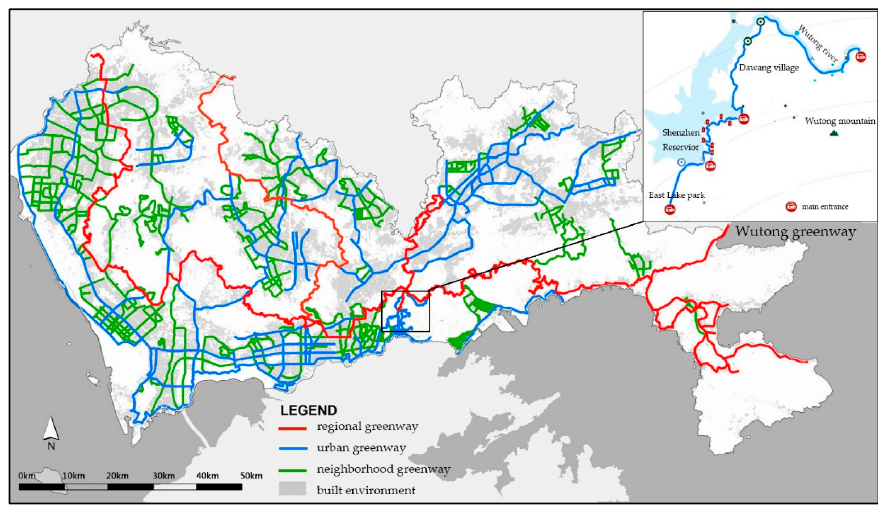
Figure 1. Shenzhen Greenway map and location of Wutong Greenway (base map from [31]). Wutong Greenway is a newly-constructed, well-equipped and well-maintained urban greenway with beautiful scenery (Figures 1 and 2). It begins from the East Lake Park of Shenzhen, winds along the east bank of Shenzhen Reservoir and the upper area of the Wutong River, crosses Dawang Village (a densely-populated residential urban village) and ends at the connection of roads that climb to Wutong Mountain. The terrain of Wutong Greenway is rugged where it crosses mountainous areas, with multi-slopes. The Greenway is approximately 3 m wide and approximately 15 km long. Five main entrances, namely East Lake Park Entrance, Liantang Entrance, Xianhu Entrance, Dawang Entrance and Wutong Mountain Entrance, connect the greenway with the urban residential area. Wutong Greenway was built with a total investment of approximately 69 million yuan during 2013 and 2014 and was open to the public by the end of 2014. Since its opening, it has become a popular public destination for residents all over the city and has been praised as the most beautiful greenway in Shenzhen. Although only approximately 50,000 residents live within 1000 m of Wutong Greenway, the estimated total number of visitors to Wutong Greenway in 2016 is 1.11 million [32].